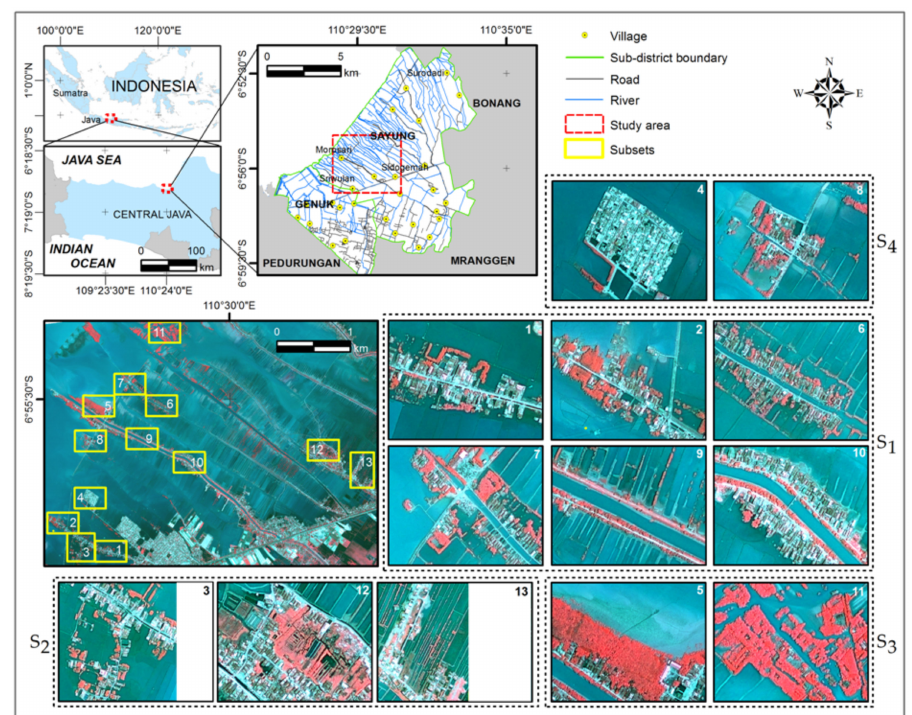
Figure 1. The study area, located in Sayung sub-distric, Central Java Province, Indonesia. It is presented here as a false colour composite of a Pleiades image with red colour representing the vegetation, bluish green showing water area, and greyish and white pixels showing the built-up area. Yellow rectangles represent several the selected sites for this work, and black-dashed rectangles show four groups of